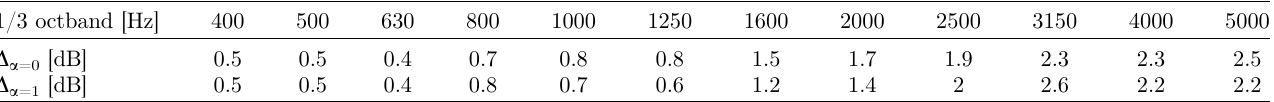
Table 2. Effect of the impedance of the source on the TL (only differences are shown). Results are calculated for two modal distributions ( a = 0 and a = 1).